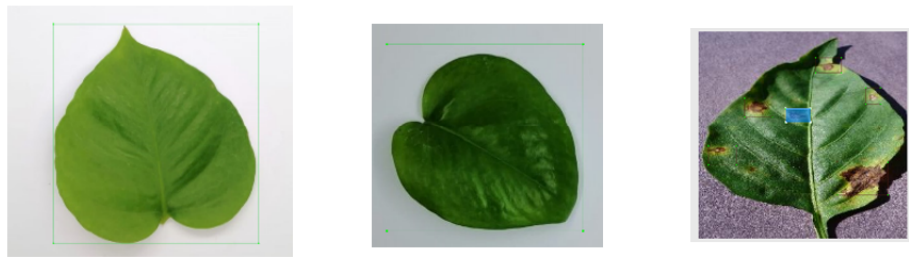
Figure 6. Plant village dataset with bounding